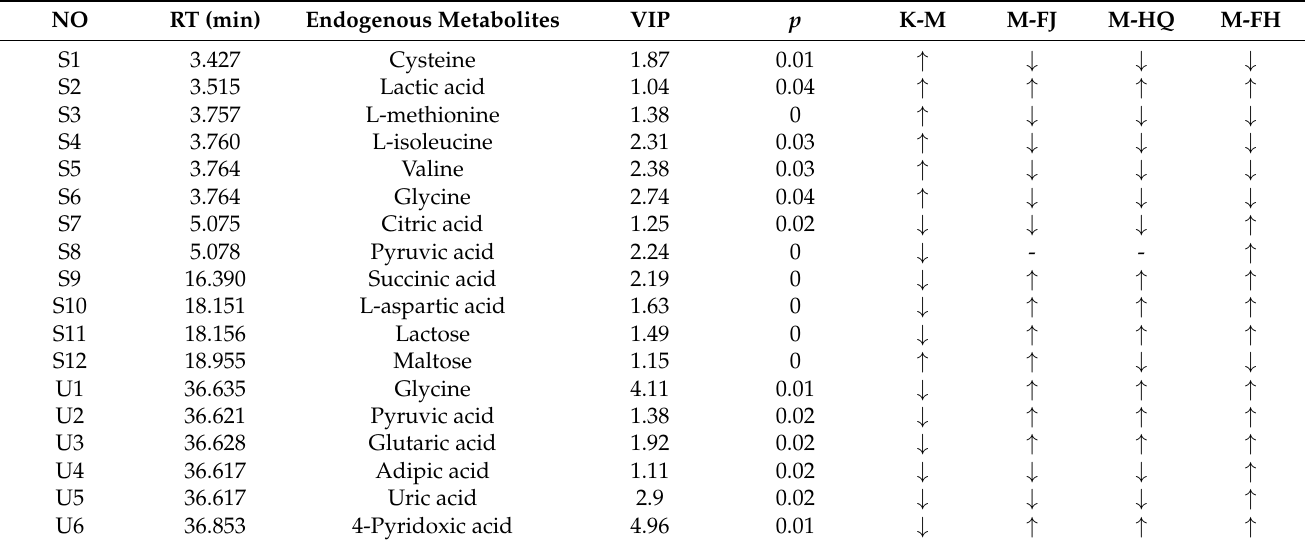
Table 1. Difference in potential biomarkers in groups of control group rats, nephrotic syndrome rats, and rats treated with FJ, HQ, and